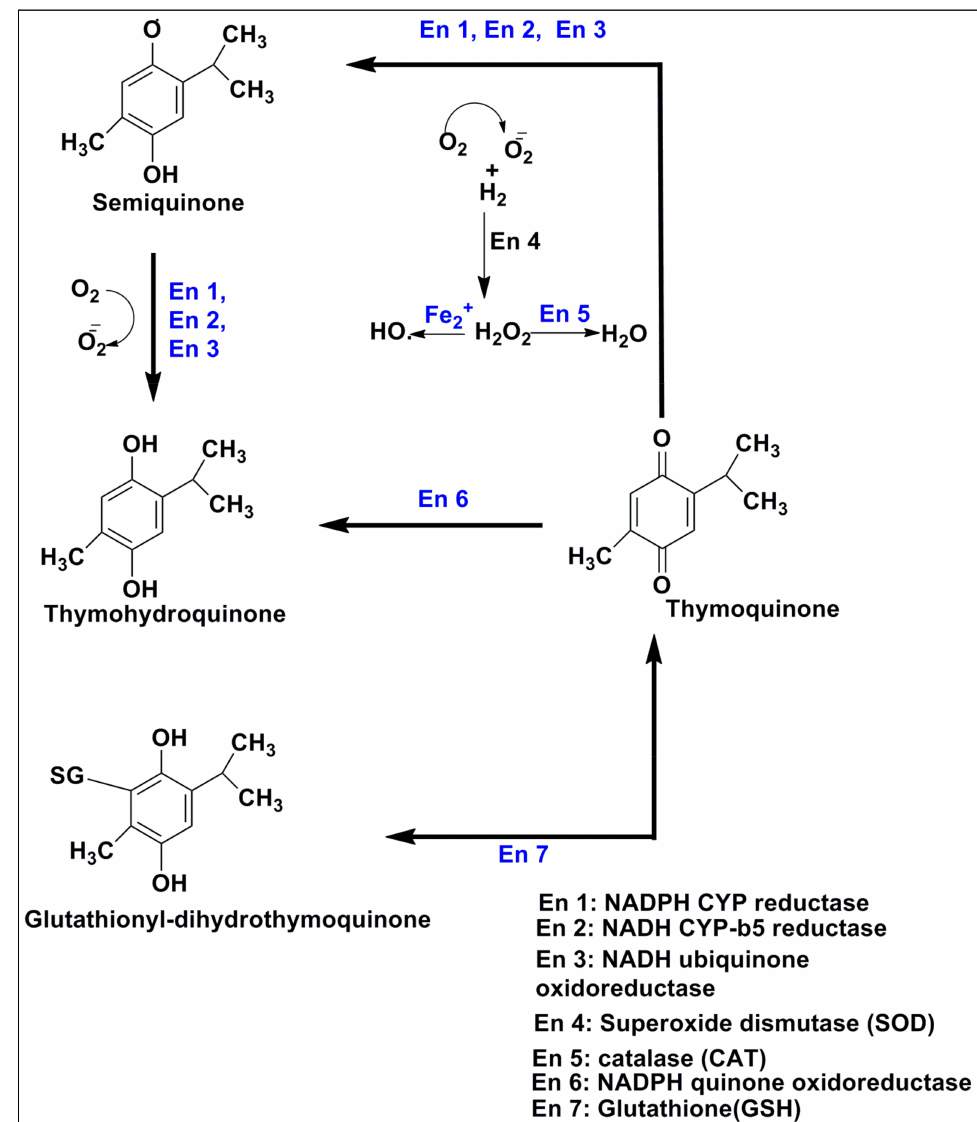
Figure 2. Enzymatic catalytic pathway of TQ under physiological